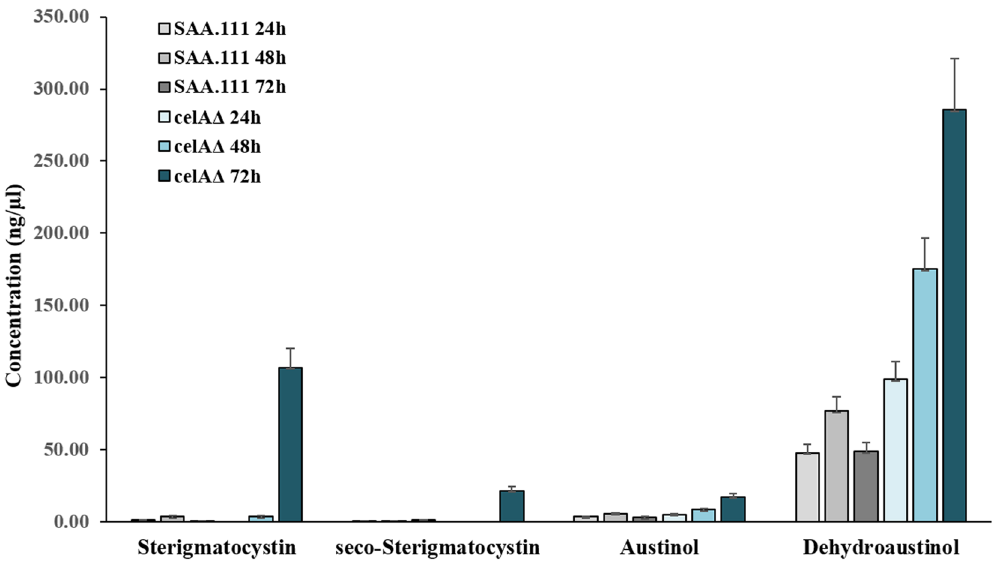
Figure 7. Quantification of some secondary metabolites in the control and celA Δ